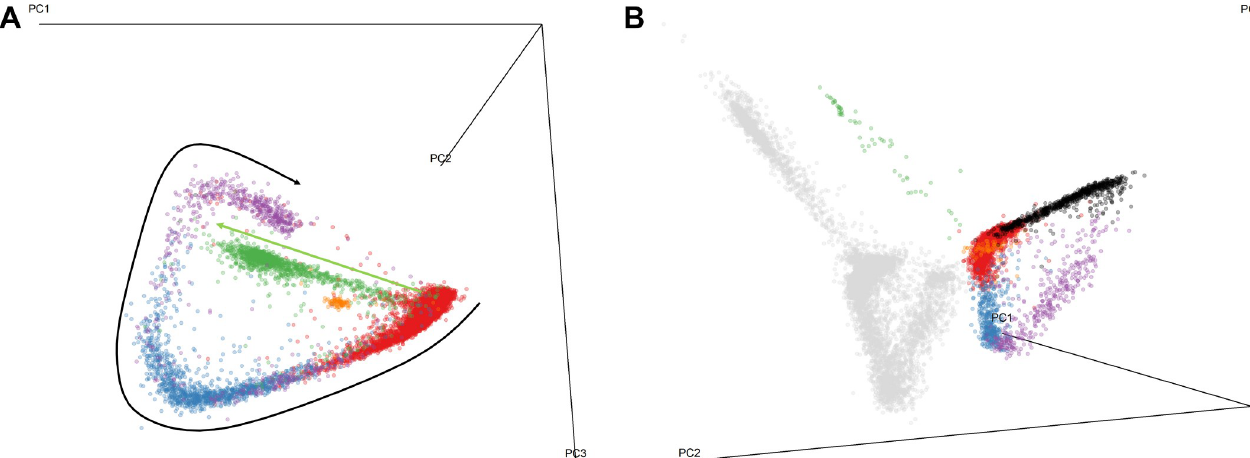
Fig 1. PCAs of the individual P . vivax transcriptomes. (A) PCA of 9,215 P . vivax parasites using 13,054 windows of 500 bp with at least 0.25% of the reads of one parasite. Each dot represents a single parasite transcriptome and is colored based on the expression of 60S ribosomal protein L34 (red), AMA1 (blue), MSP3 (purple), Pvs25 (green), and MGET (orange). The arrows represent the trajectories used to calculate developmental pseudotimes for asexual (in black) and female gametocytes (in green). (B) PCA calculated jointly from the data of 9,215 P . vivax parasites and 4,884 P . berghei parasites using the expression levels of orthologous genes. The gray dots represent P . vivax parasites and the colored dots show P . berghei parasites according to their developmental stages (yellow, rings; red, trophozoites; blue, schizonts; green, female gametocytes; orange, male gametocytes). Underlying data plotted in panels A and B are provided in S1 Data. bp, base pairs; PCA, principal component